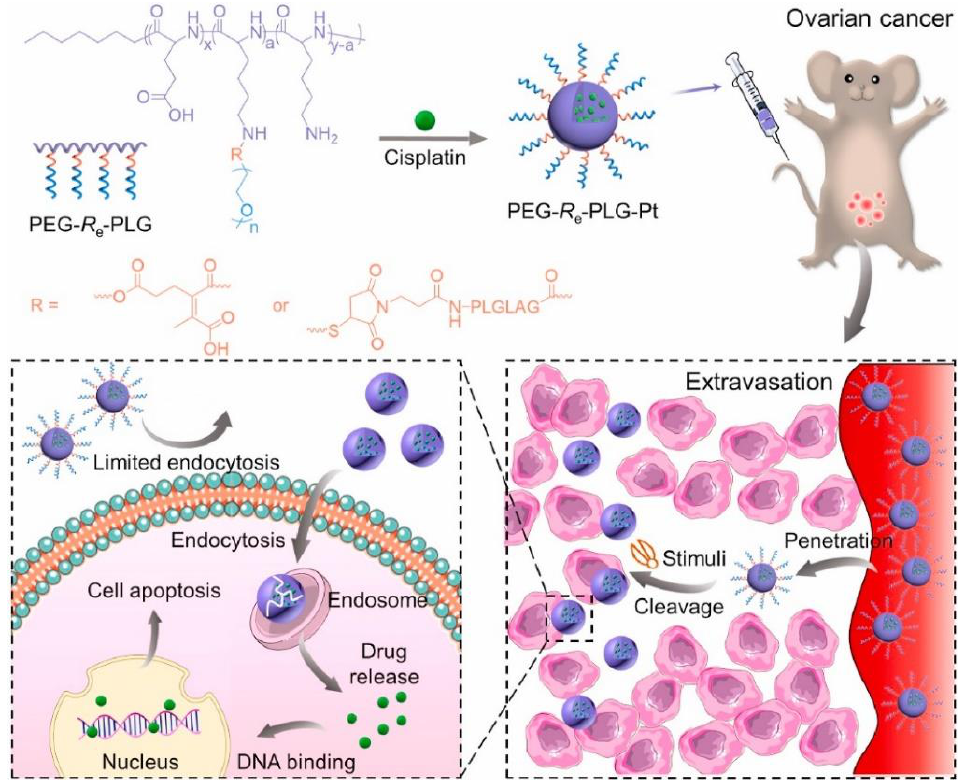
Figure 10. Schematic illustration for preparation of PLG-CDDP nanoformulations with detachable PEG response to tumor microenvironments for enhanced therapy of peritoneal metastasis of ovarian cancer. Upon reaching the tumor tissue, dePEGylation is triggered by acidic pH or overexpression of MMP, and the nanoformulations without a PEG shell enter and deliver the drug to the cancer cells more effectively, leading to improved antitumor efficacy. Reprinted with permission from Ref.